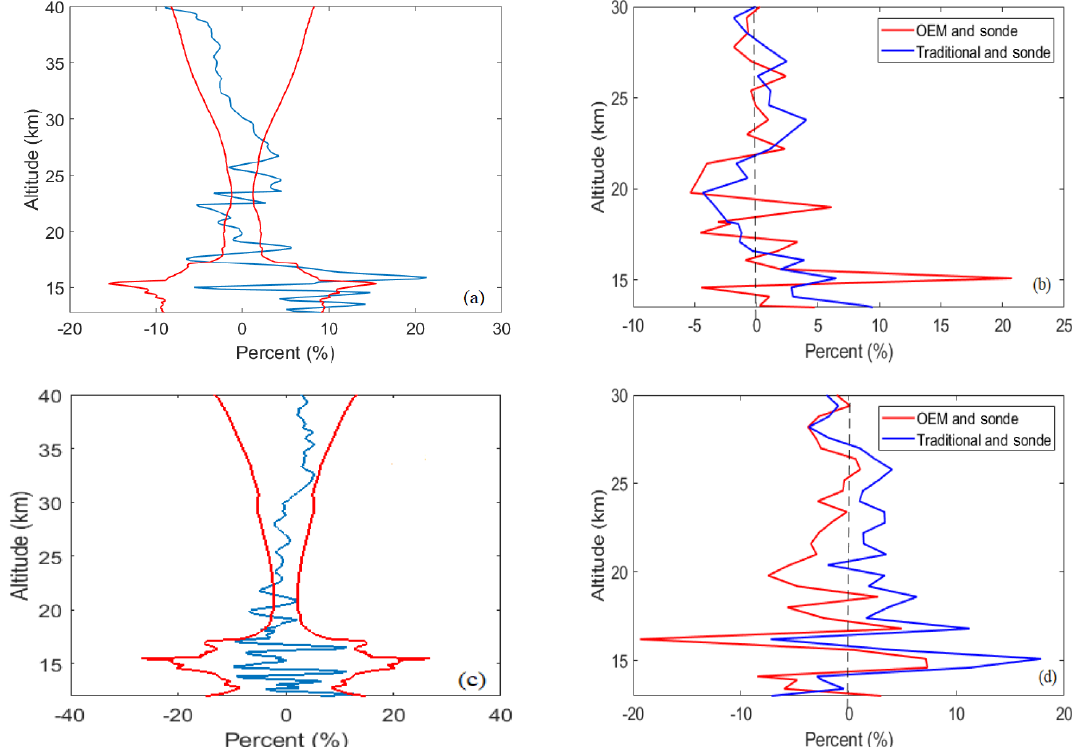
Figure 14. For the night of 14 July 2017, (a) the percentage difference between the traditional method and the OEM retrieval (blue curve) plotted within the envelope of the total statistical uncertainty of the two methods (red curve). The agreement between the two lidar ozone determinations is within the statistical uncertainty above 17km. (b) The red curve is the percentage difference between the OEM retrieval and sonde measurements. The blue curve is the percentage difference between the traditional method and sonde measurements. Panels (c) and (d) are the same format as (a) and (b) for the night of 20 July